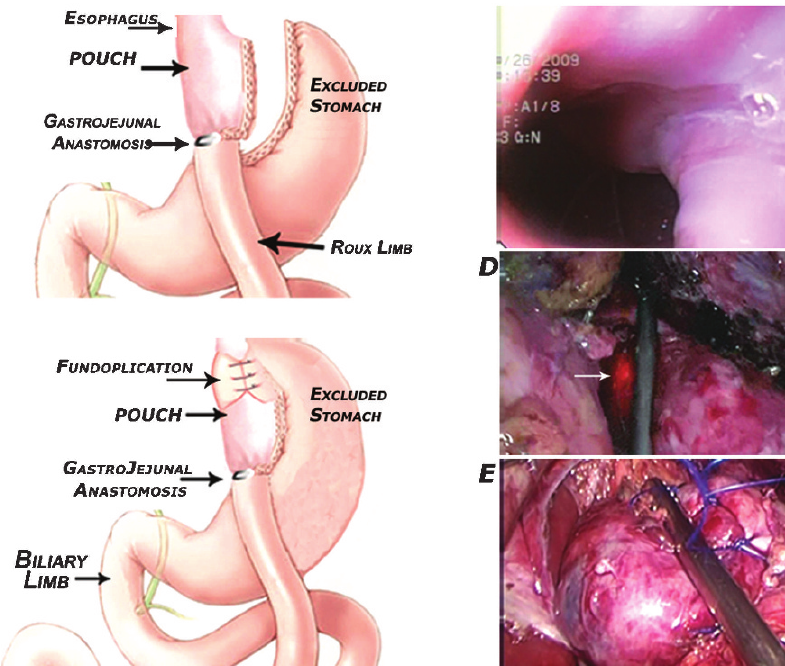
Figure 1 - The proposed technique: A - Surgical anatomy post-RYGB. B - Surgical anatomy post-fundoplication. The LES was reinforced by wrapping the excluded stomach around the lowest portion of the esophagus. C - Endoscopic view of the 3.5-cm pouch and the 13- mm GJ. D - Endoscopic-guided fundoplication delimiting the z-line (arrow shows transillumination with the endoscope). E - Final result of the 360 ˚ short, floppy fundoplication. Abbreviations: RYGB – Roux-en-Y gastric bypass; LES – lower esophageal sphincter; GJ – gastrojejunostomy.